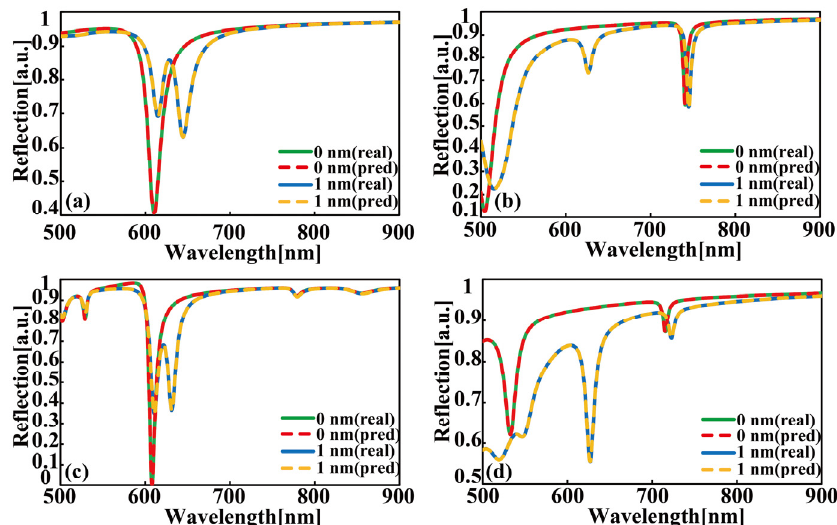
Figure 4. Comparison of the reflection spectra calculated by the RCWA simulation (real, solid lines) and forward prediction network (pred, dotted lines). ( a – d ) The reflection spectra incident at 20 degrees with different WS 2 thicknesses for S1, S3, S4, and S5 from top to bottom, respectively. Concretely, the values of structural variable g are given as follows: S1: LiF, 85 nm; S3: PMMA, 22 nm; S4: TiO 2 , 65 nm; S5: PMMA, 100 nm. There are distinct differences between the forward prediction network and the re ‐ ward function network, which are mainly reflected in the network structure, input, and